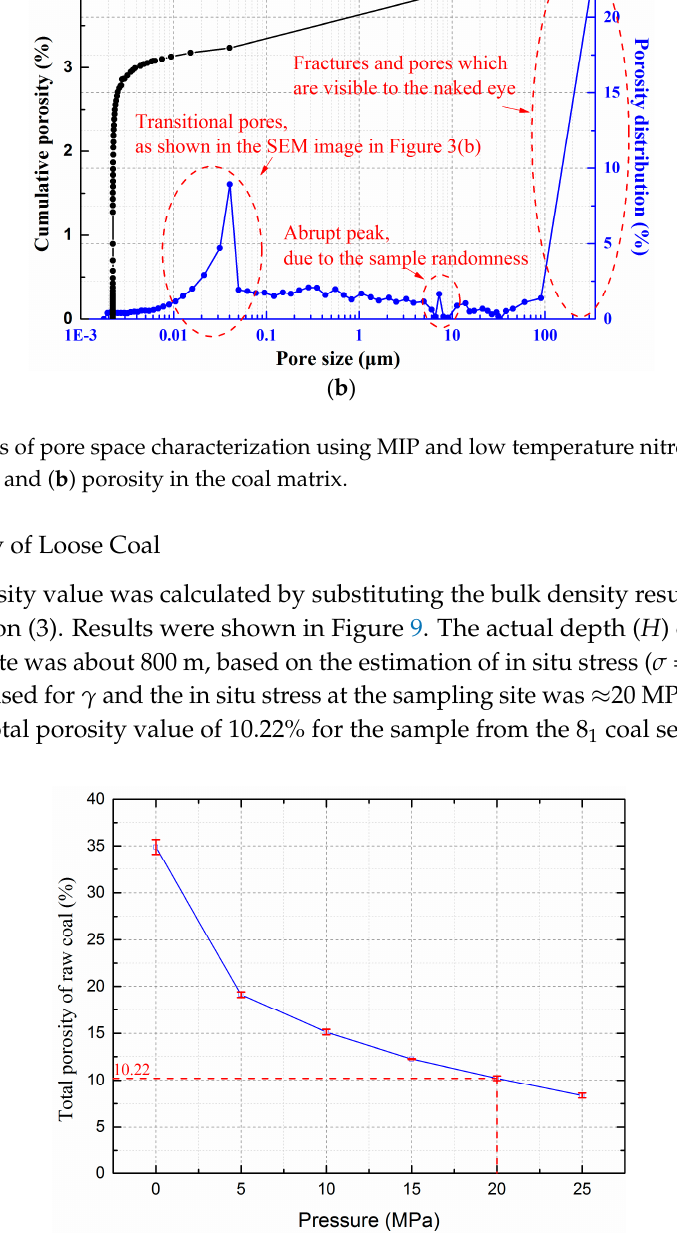
Figure 9. Curve of total porosity for a sample of coal from the 8 1 coal seam.